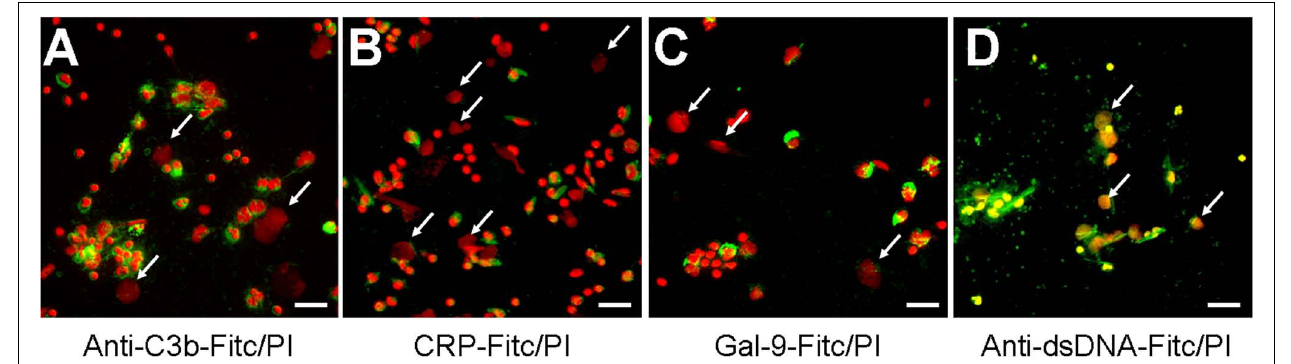
FIGURE 3 |The dead cells’ ligands C3b, CRP, and galectin-9 do not opsonize NETs. (A–D) Isolated PMN were incubated with MSU for 5 h at 37 ◦ C and then fixed with 1% PFA. Cytospins were prepared and NETs